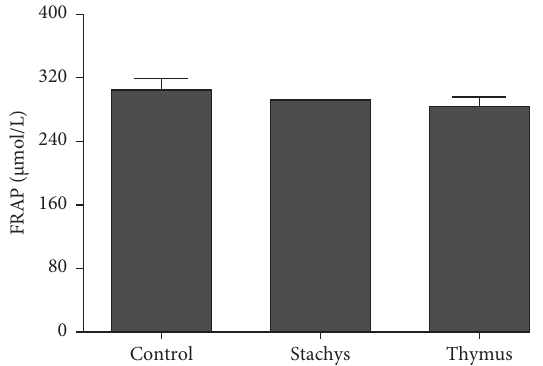
Figure 5: The total antioxidant activity of S. pilifera Benth and T. daenensis Celak extracts for 24h in HepG2